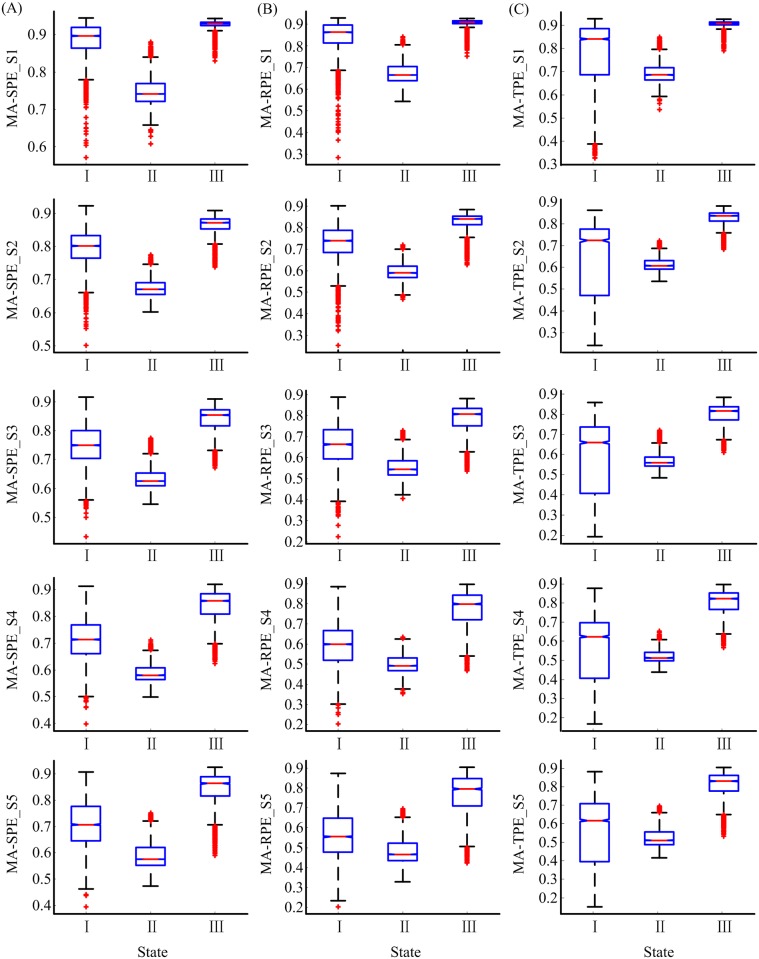
The statistical box plots of MA-SPE, MA-RPE and MA-TPE at scale 1–5 in awake state (I), unconsciousness (II) and RoC state (III).S1-S5 represent scale 1–5, respectively.